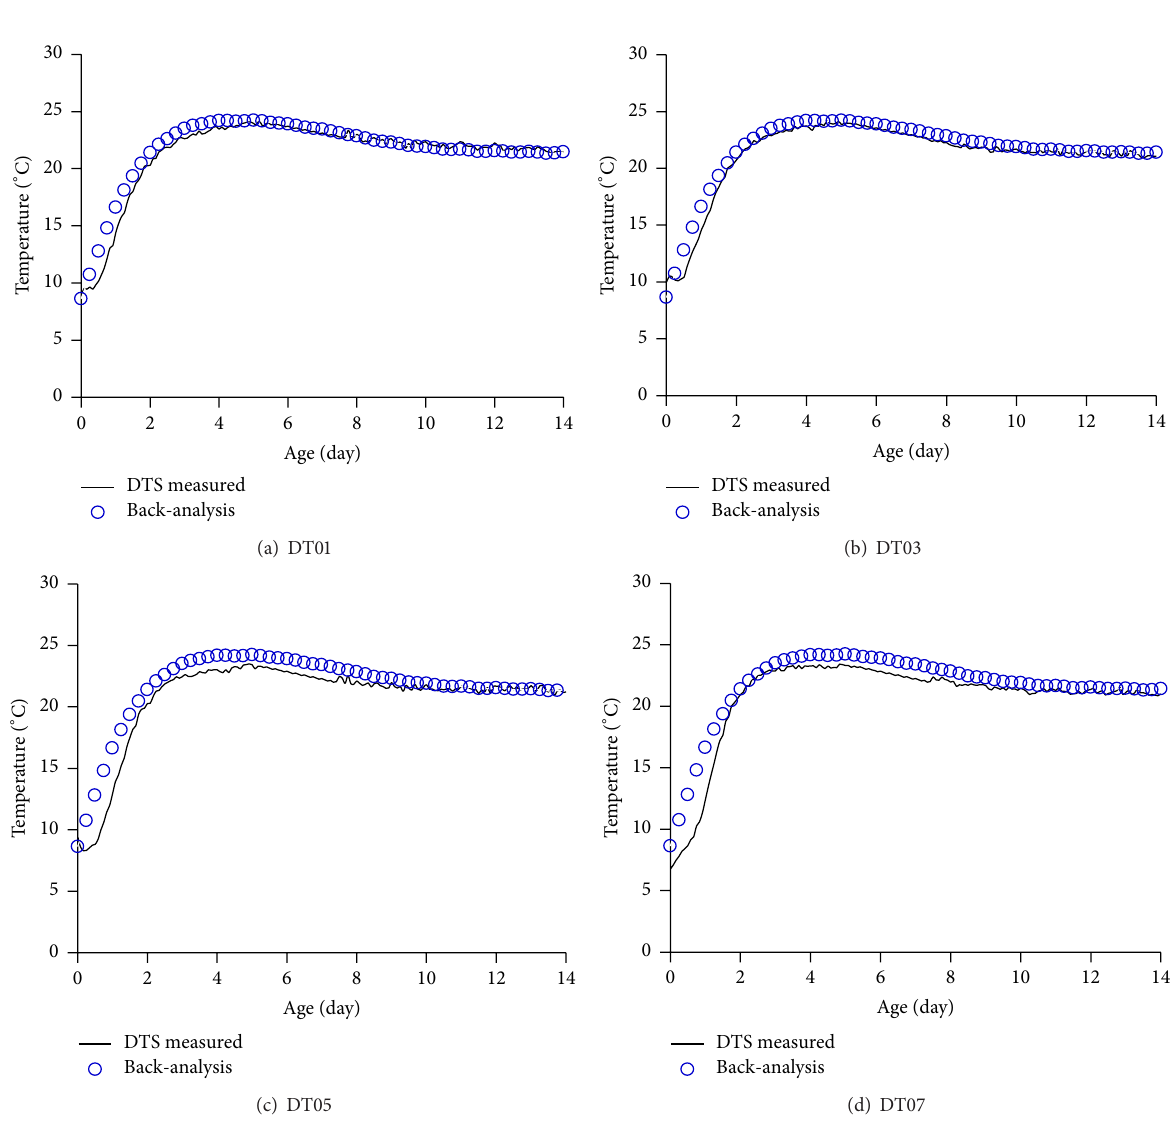
Figure 12: Comparison of DTS measured temperature and back-analysis